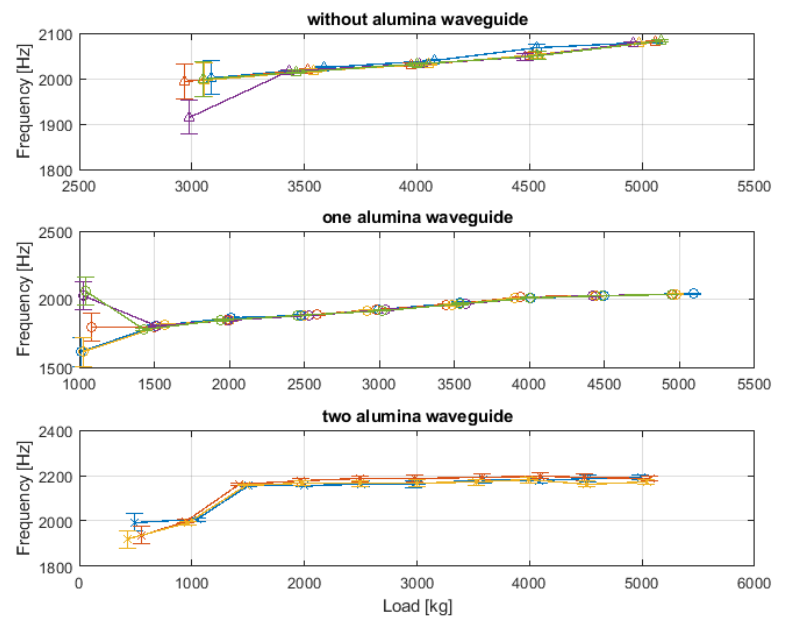
Figure 11. Dependence of the resonance frequency in the function of load determined by SAS working in three configurations: without alumina waveguide; with one alumina waveguide connecting the emitter and the sample; with two alumina waveguides connecting both emitter and receiver with the sample. Green and blue curves correspond to the subsequent measurements.